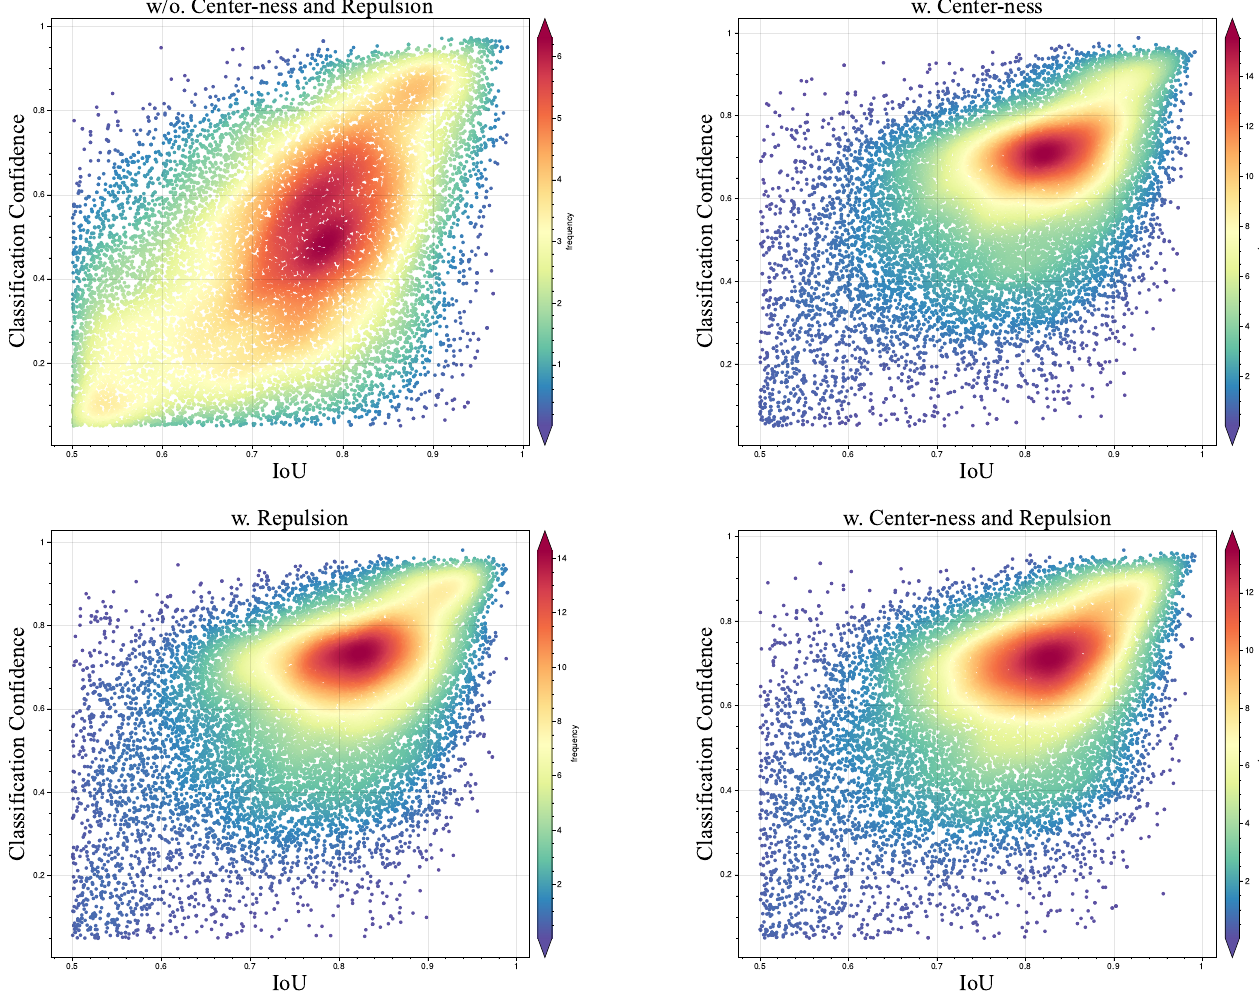
Figure 8. The correlation between the localization scores and classification confidence of predicted oriented boxes under four conditions: no center-ness and no repulsion constraints, center-ness constraint only, repulsion constraints only, and both center-ness and repulsion constraints. All the experiments adopt ResNet-50 with FPN as the backbone. The baseline is Rotated RepPoints